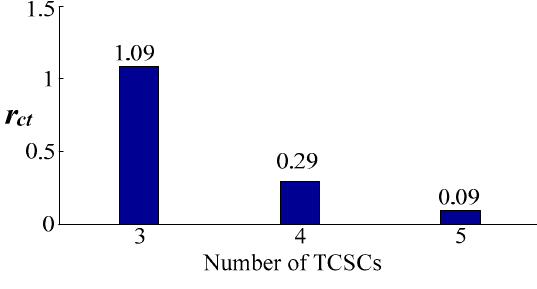
Figure 6. Change trend of r ct with the number of TCSCs.